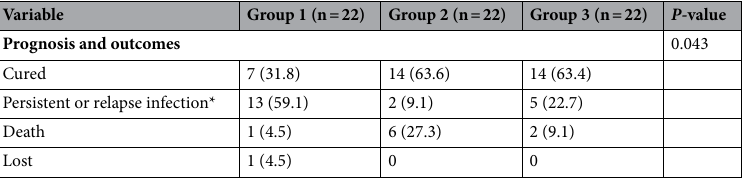
Table 4. Comparison of the outcomes between three groups in 66 HIV-negative participants. Data are expressed as number and percentage (%). Fisher’s exact test and Kruskal–Wallis H test were used to determine statistical significance among the groups. P < 0.05 was taken as significant. Group 1 = patients with TM and NTM co-infections, Group 2 = patients with TM infection only, and Group 3 = patients with NTM infection only. *Persistent or Relapse infection: In Group 1, the infection condition of patients may have been only TM persistent infection, only TM recurrent infection, only NTM persistent infection, only NTM recurrent infection, both TM persistent and recurrent infection, both NTM persistent and recurrent infection, both TM persistent infection and NTM recurrent infection, or both NTM persistent infection and TM recurrent infection. Detailed prognostic information for Group 1 can be found in Table 3 which described the treatment and patient outcomes in Group 1. In Group 2, there was one case with persistent infection and one case with relapse infection. In Group 3, there was one case with persistent infection and four cases with relapse